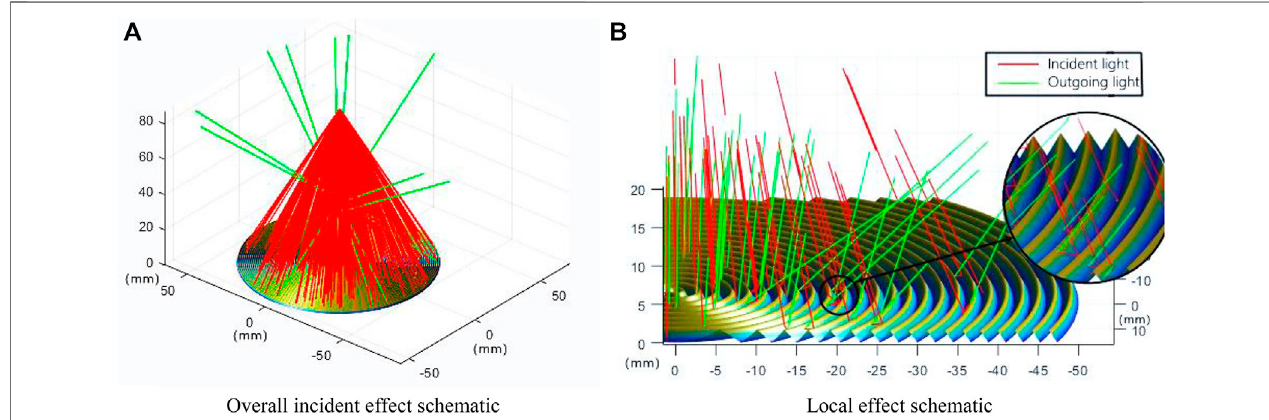
FIGURE 4 | Light re fl ection path inside the V-groove simulated by the multiple re fl ection method (point light resource height is 20 cm). (A) Overall incident effect schematic and (B) local effect schematic.